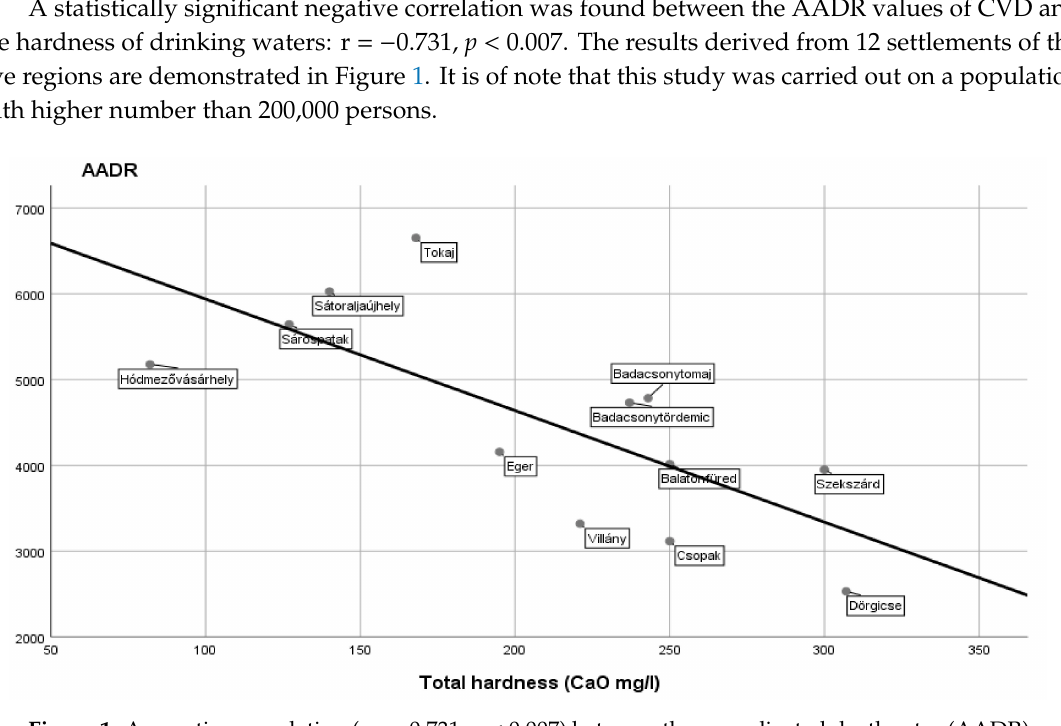
Figure 1. A negative correlation (r = − 0.731; p < 0.007) between the age-adjusted death rates (AADR) values due to cardiovascular diseases and total hardness of drinking water found in the settlements of five regions in a population larger than 200,000